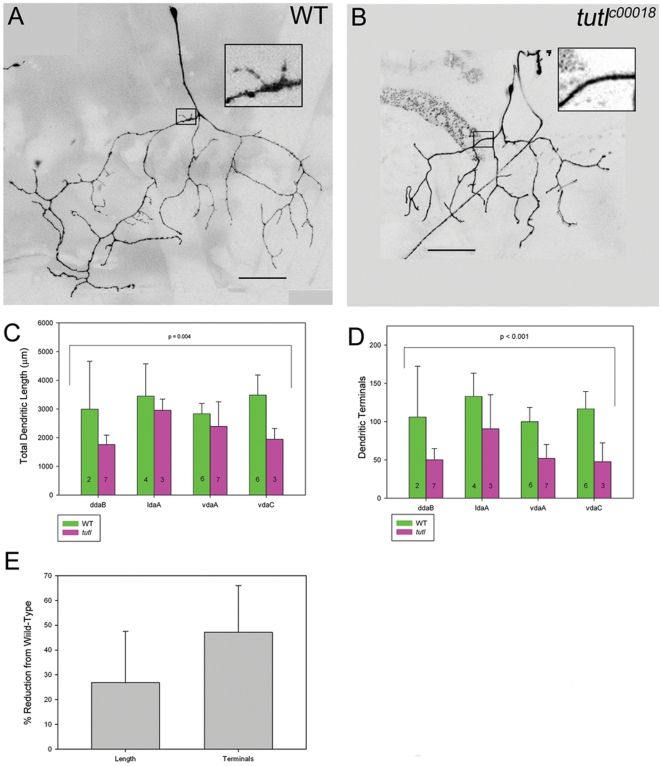

tutl is required to promote both dendritic branching and extension in class II da neurons.(A) Wild-type class II vdaA neuron. Note terminal branching complexity in inset. (B) tutl mutant class II vdaA neuron. As compared to wild-type, tutl mutant class II da neurons display an overall reduction in dendritic branching particularly with respect to terminal branching and to a lesser extent overall dendritic length. Note loss of terminal dendritic branches in inset. Images taken at 40X magnification and size bar represents 50 microns. (C) Quantitative analyses of overall dendritic length revealed a significant reduction in tutl mutant class II da neurons relative to wild-type controls (two way ANOVA, p<0.001). The n value for each class II da neuron subtype for both wild-type and tutl mutants is indicated on the bar graph. (D) Quantitative analyses of the total number of dendritic terminals revealed a significant reduction in tutl mutant class II da neurons relative to wild-type controls (two way ANOVA, p<0.001). The n value for each class II da neuron subtype for both wild-type and tutl mutants is indicated on the bar graph. (E) Quantitative analyses revealed an average 27% reduction in overall dendritic length relative to an average 46% reduction in the number of dendritic terminals in tutl mutant class II da neurons relative to wild-type controls. For these analyses each of the four class II da neuron subtypes (ddaB, ldaA, vdaA, vdaC) in both wild-type and tutl mutants was compared. The average percent reduction from wild-type in tutl mutants of each of the four subtypes is reported.